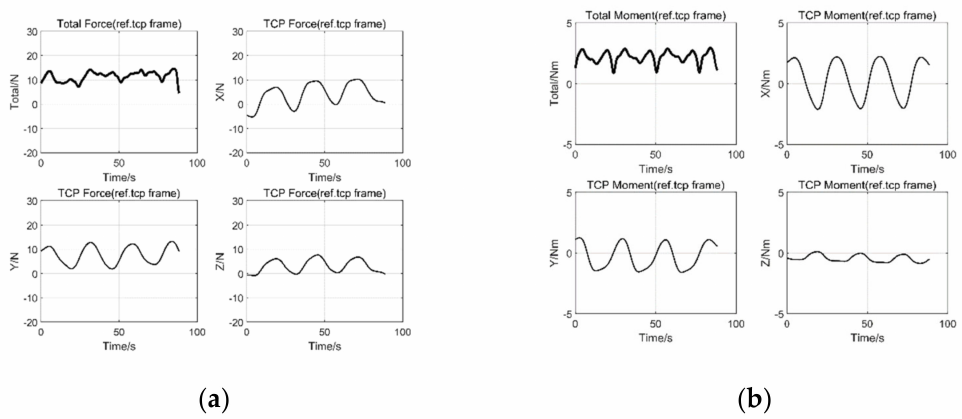
Figure 12. The interaction force and moment between the handle and the subject’s hand. ( a ) is the interaction force between the handle and subject’s hand; ( b ) is the moment between the handle and subject’s hand.